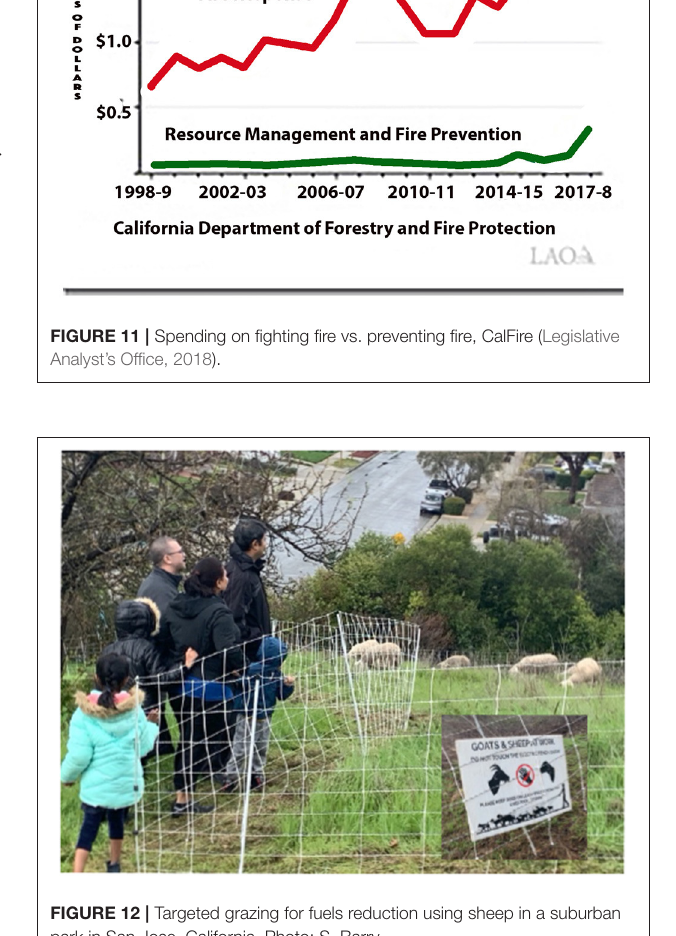
of California’s forestland, by 2025 using brush clearing, logging, and prescribed fires (United States Forest Service and State of California, 2020). California has budgeted $1 billion for